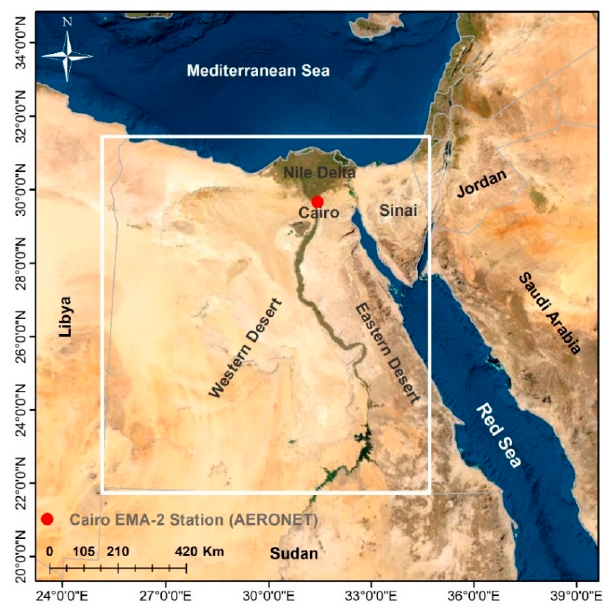
Figure 1. Location map of Egypt; the white box represents the domain (25°2 ′ 36 ″ E, 21°49 ′ 50 ″ N & 34°54 ′ 39 ″ E, 31°52 ′ 46 ″ N) selected for data analysis, and the red point shows the Cairo Egyptian Meteorological Authority (EMA-2) Aerosol Robotic Network (AERONET) station.